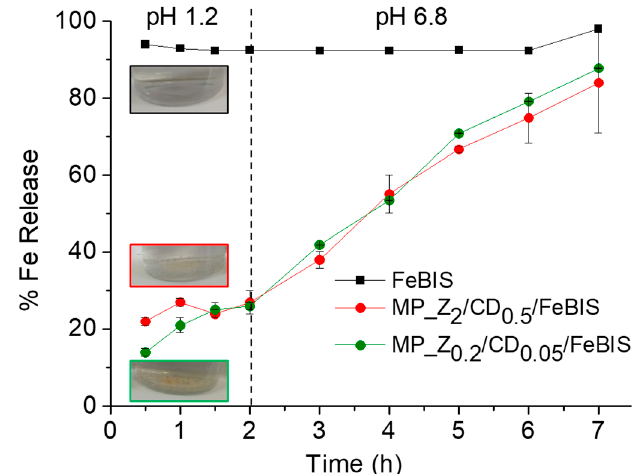
Figure 6. Release of iron from micropowders prepared at FeBIS theoretical loading of 2% (red) and 8% w / w (green) in simulated gastric fluid (pH 1.2) and simulated intestinal fluid (pH 6.8). Free FeBIS is reported as control. Data are the mean of three separate experiments ± SD.